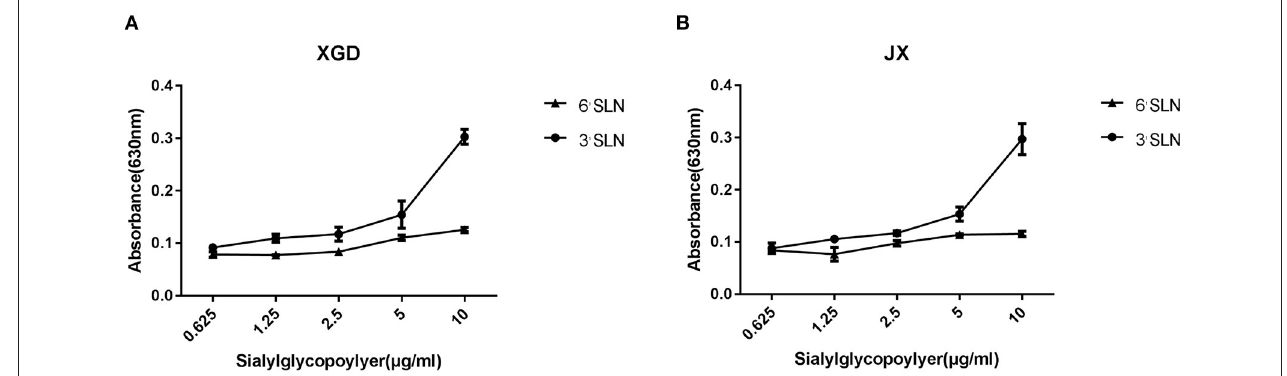
FIGURE 2 | Sialic acid–binding activity assay of the JX and XGD strains of H5N6. The synthetic sialyl glycopolymers Neu5Aca2-3Galb1-4GlcNAcb-PAA-biotin (3 ′ SLN) and Neu5Aca2-3Galb1-4GlcNAcb -PAA-biotin (6 ′ SLN) were used to evaluate the receptor-binding properties of XGD (A) and JX (B) via solid-phase binding assays. Data are presented as the mean ± standard deviation of triplicate experiments. Error bars indicate one standard deviation.